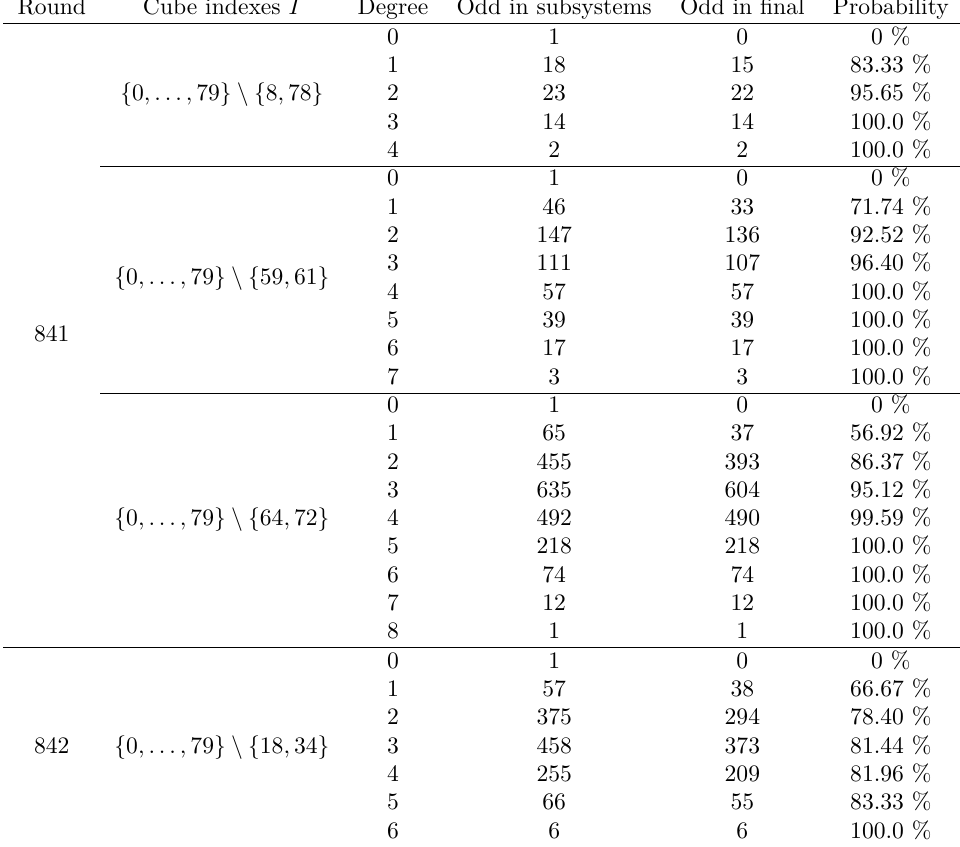
Table 3: Statistics of monomials obtained by recovering the superpolys for 841- and 842-round Trivium